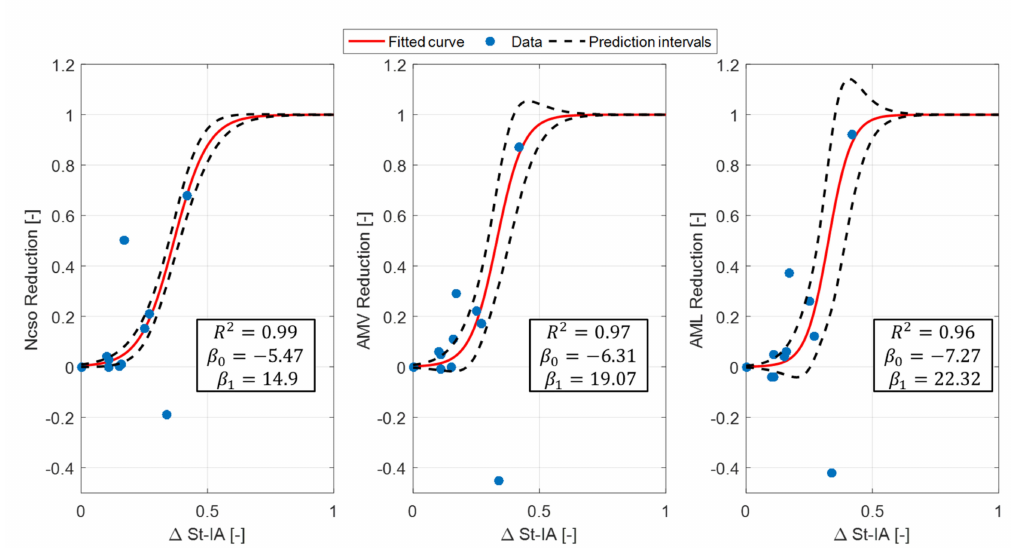
Figure 3. Logistic regressions of average number of CSO events per year (N CSO, left panel), annual mean volumes (AMV, mid panel) and annual mean loads (AML, right panel) as a function of the maximum increase of storage capacity per impervious area ( ∆ St-IA ). Including fitted lines, their 95% prediction intervals (red and magenta lines